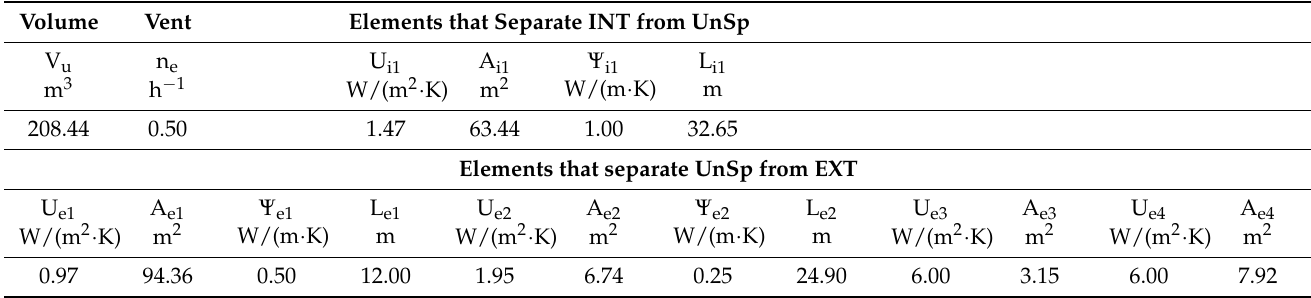
Table 15. Geometric and physical characteristics of Garage